Question: Give a one-sentence summary of this figure.
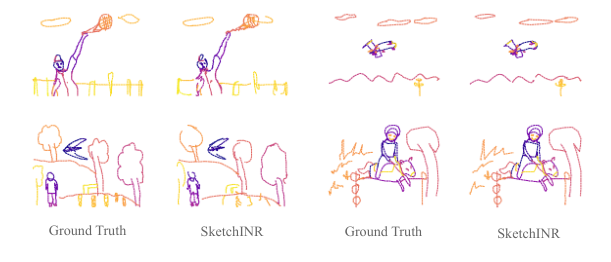
Answer: Qualitative reconstruction results for neural sketch rep- resentations. SketchINR is uniquely able to scale to sketches of Sketchy and FS-COCO complexity.